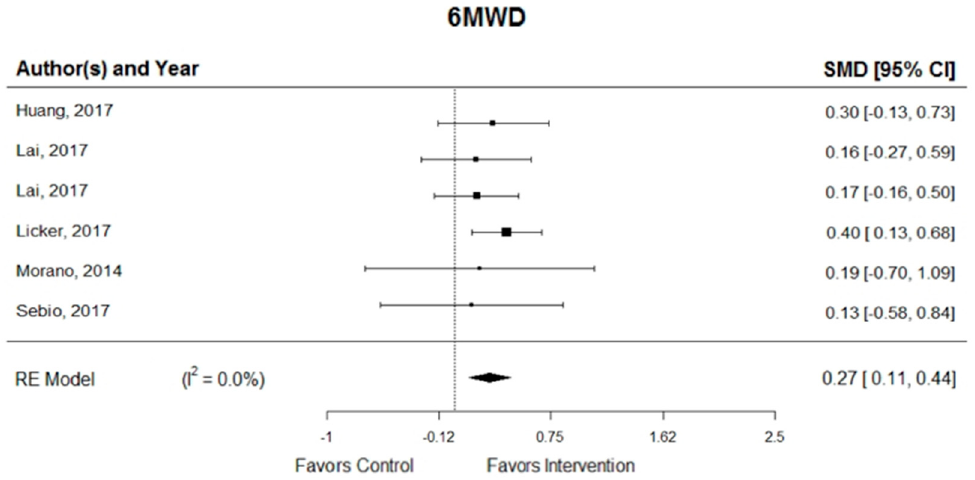
Figure 2. Pooled changes in functional capacity, six-minute walk distance (6MWD) by group. SMD = standardized mean difference; I 2 = heterogeneity; RE = random-effects models.